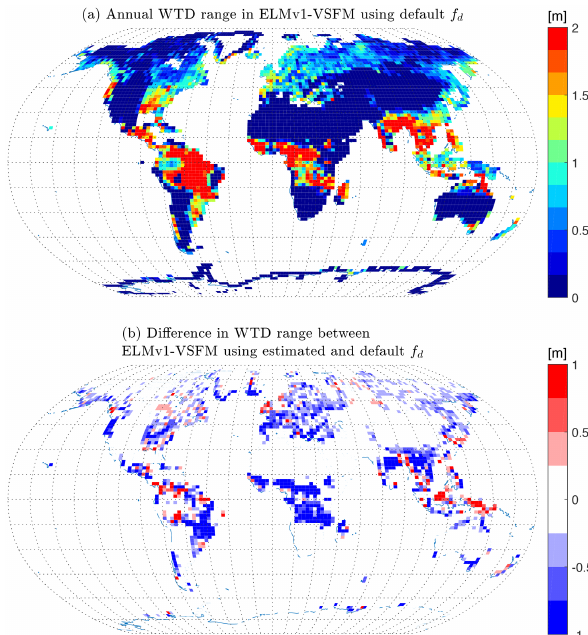
Figure 7. (a) Annual range of water table depth for ELMv1-VSFM simulation with spatially heterogeneous estimates of f d and (b) dif- ference in annual water table depth range between simulations with optimal and default f d